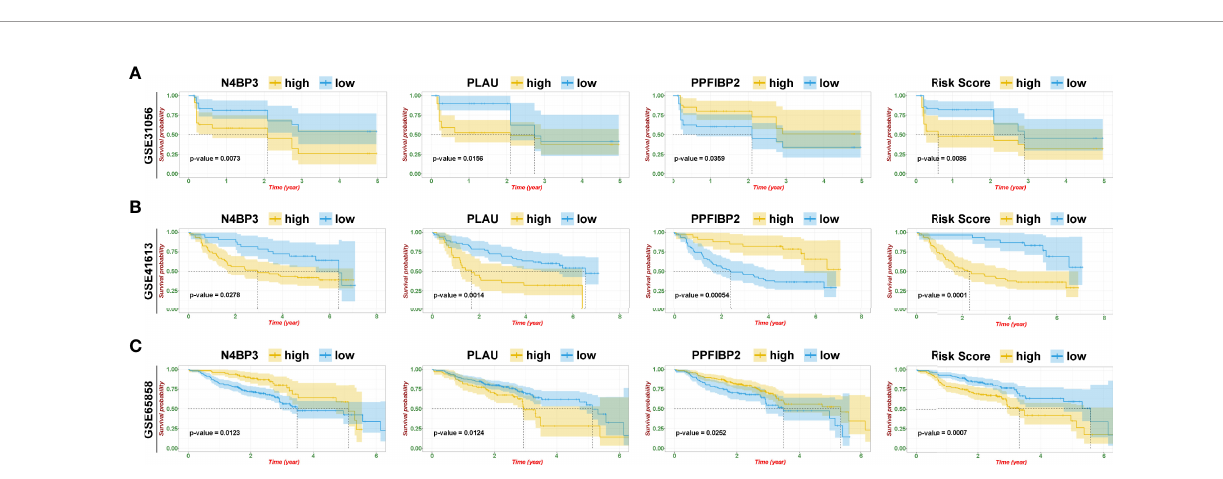
FIGURE 6 | Risk model and validation of hub genes. (A – C) Kaplan – Meier plot of hub genes and risk score in GSE31056 (A) , GSE41613 (B) , and GSE65858 (C)